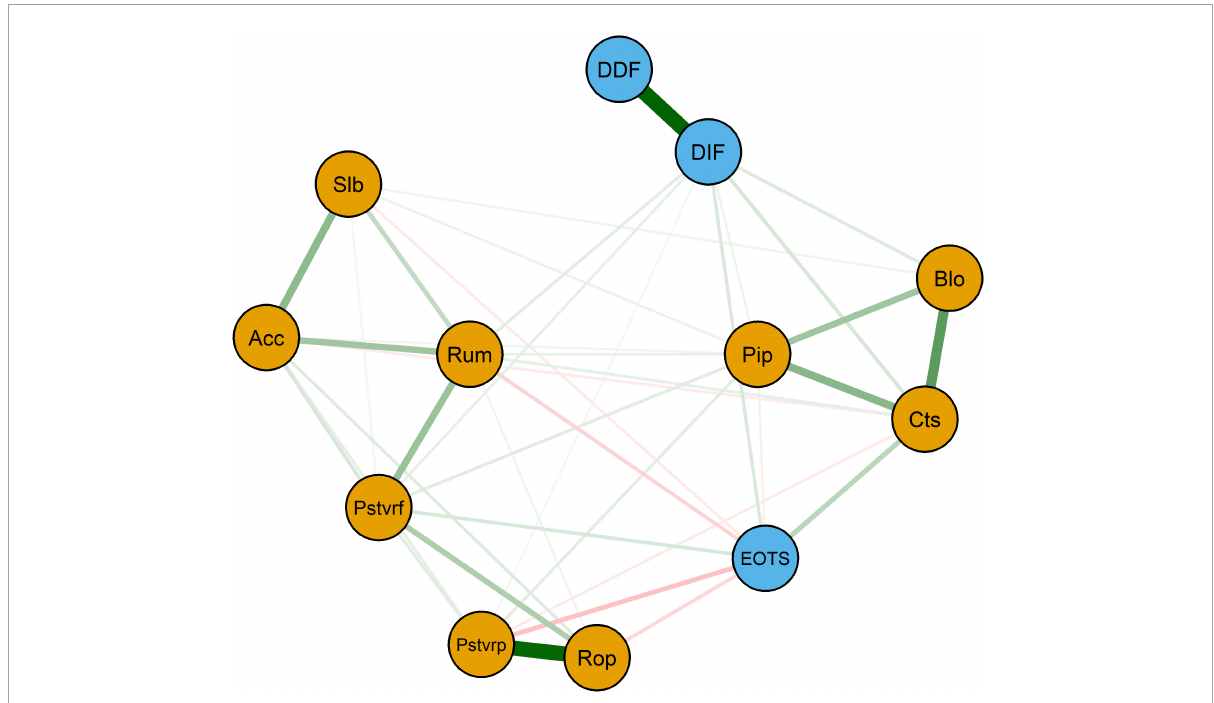
FIGURE1 Regularized partial correlation network: Network structure of the TAT and CERQ-C, based on the whole sample ( n = 560). Each subscale is represented by a node. Green connections represent positive associations, whereas red connections represent negative associations. Thicker edge (positive and negative) signifies stronger partial correlations. Slb, Self-blame; Acc, Acceptance; Rum, Rumination; Pstvrf, Positive refocusing; Rop, Refocusing on planning; Pstvrp, Positive reappraisal; Pip, putting into perspective; Cts, Catastrophizing; Blo, Blaming others; DIF, Difficulty Identifying Feelings; DDF, Difficulty Describing Feelings; EOTS, Externally-Oriented Thoughts.